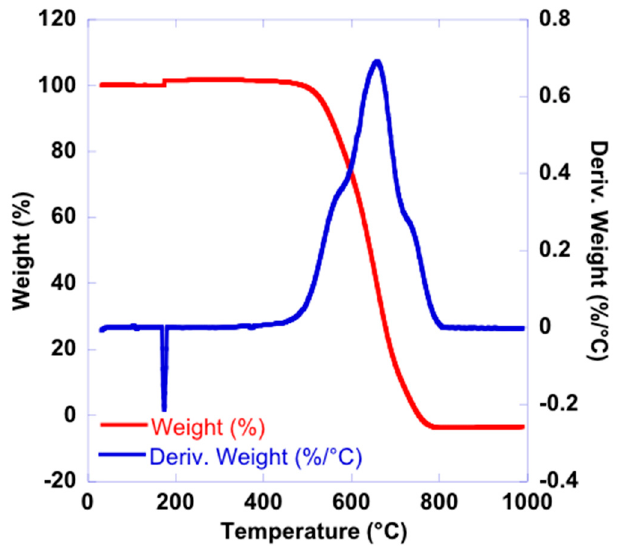
Figure 4. Thermogravimetric scan of the MW produced carbon (red curve) in air and its derivative profile (blue curve)—indicating three different carbon oxidation temperature peaks.